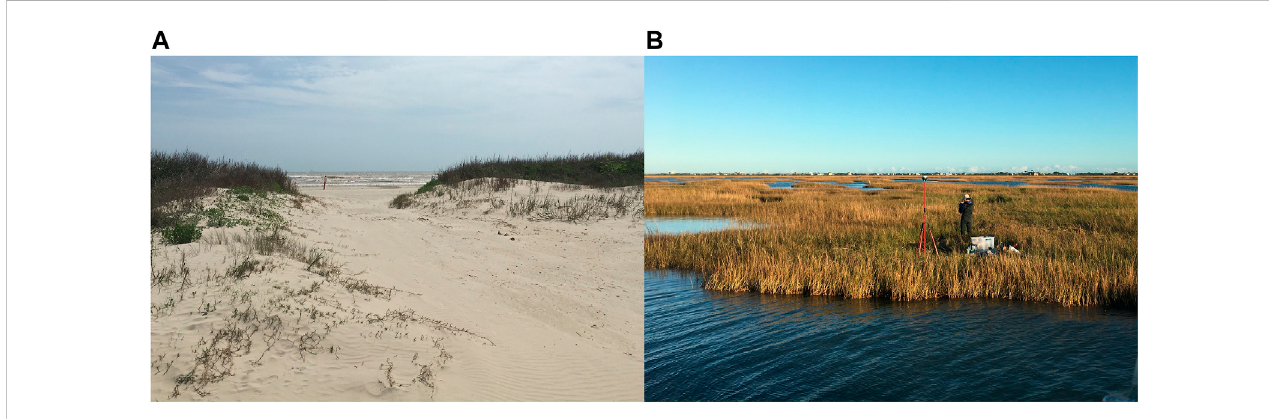
FIGURE 1 Engineered vegetated dune with cut for beach access (A) and researcher surveying a wetland system (B) as part of a scienti fi c study on NNBF. The location of both photos is Galveston,